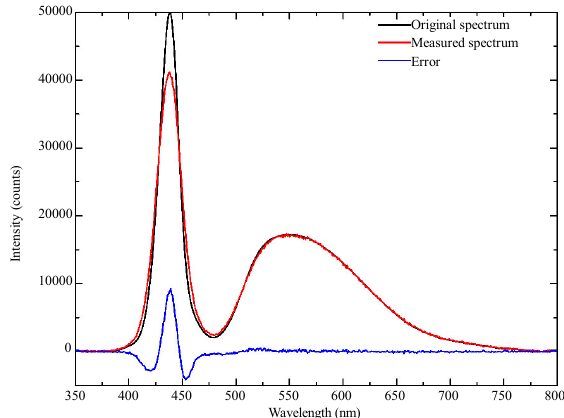
Fig. 2 Original spectrum, measured spectrum and error of them of the white LED 1#.